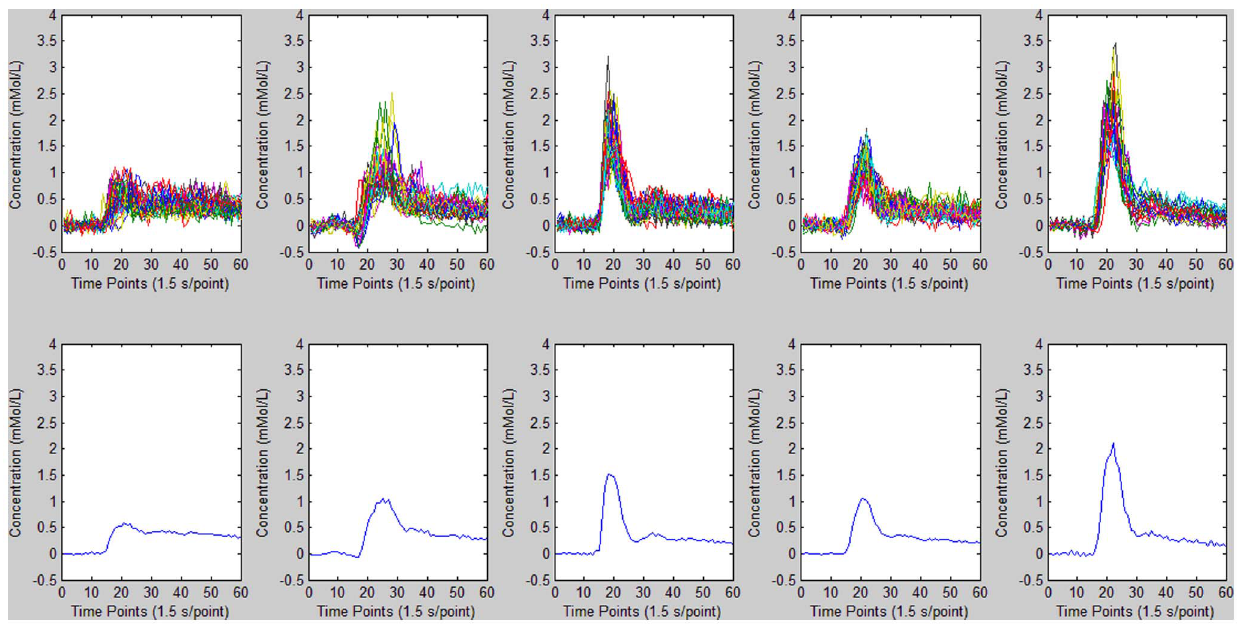
Figure 6. K -Means cluster analysis results for AIF detection. Top: time–concentration curves for different clusters. Bottom: mean curve for M values of 6.7346e-004, 0.0036, 0.0138, 0.0066, and 0.0148, respectively. The mean curve for M =0.0148 was thus selected to represent the estimated